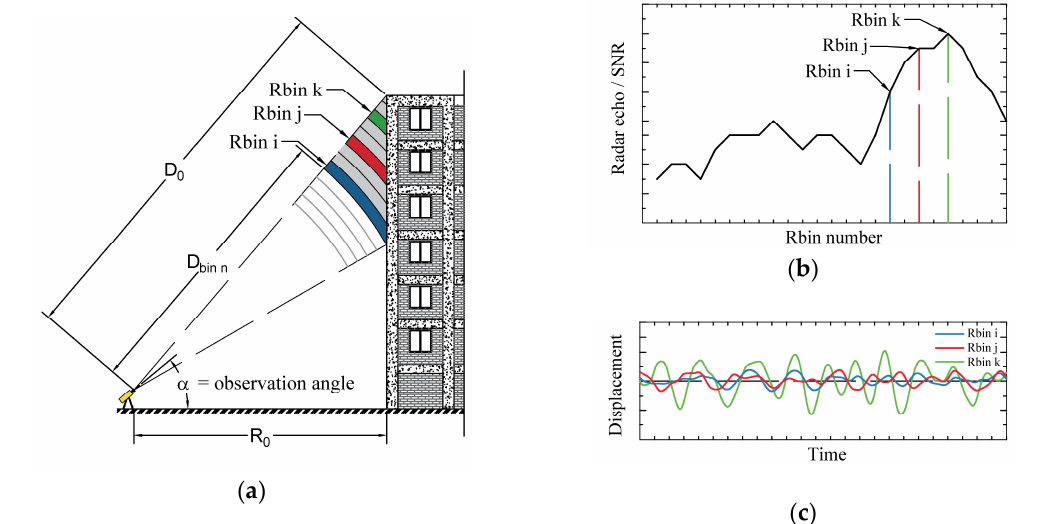
Figure 8. Procedure to record the displacement recordings of a building: ( a ) RAR sensing; ( b ) Rbins selection; ( c ) displacement–time recording of the selected Rbins (see explanation above).